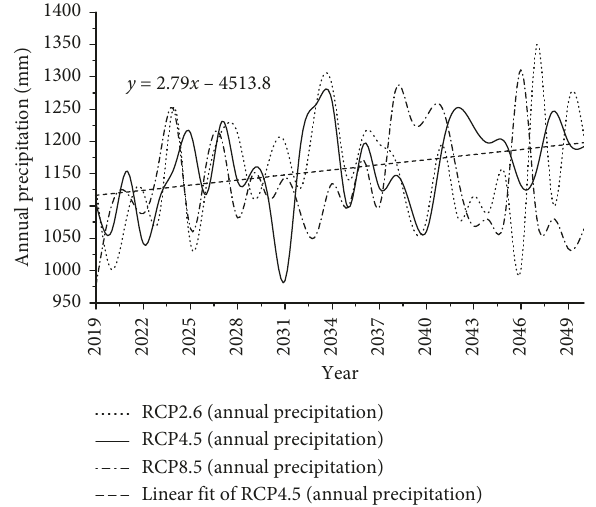
Figure 9: Evolution trends of annual precipitation from 2019 to